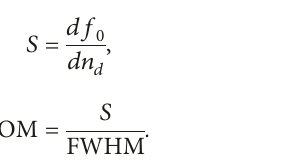
Figure 3: Reflectance of an Au/PDMS grating with Λ � 190 μ m, H � 95 μ m, FF � 0.5, and t function of frequency. An inset is the | H y | field distribution along one unit of the grating